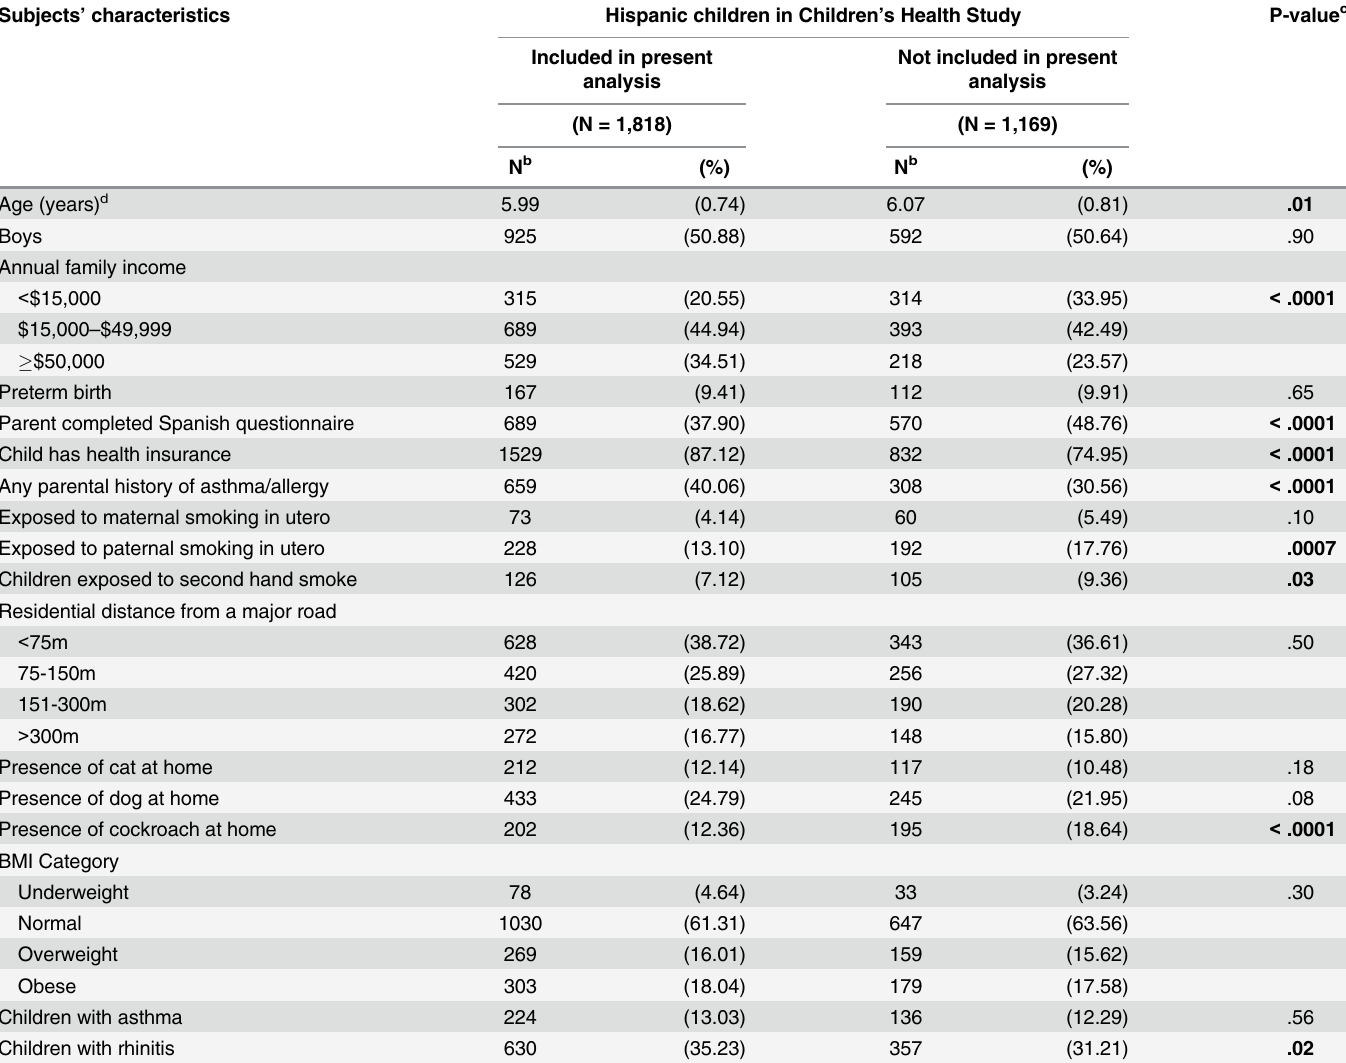
Table 2. Comparison of Hispanic children in Children's Health Study who are included in the present study vs. those who were not included.